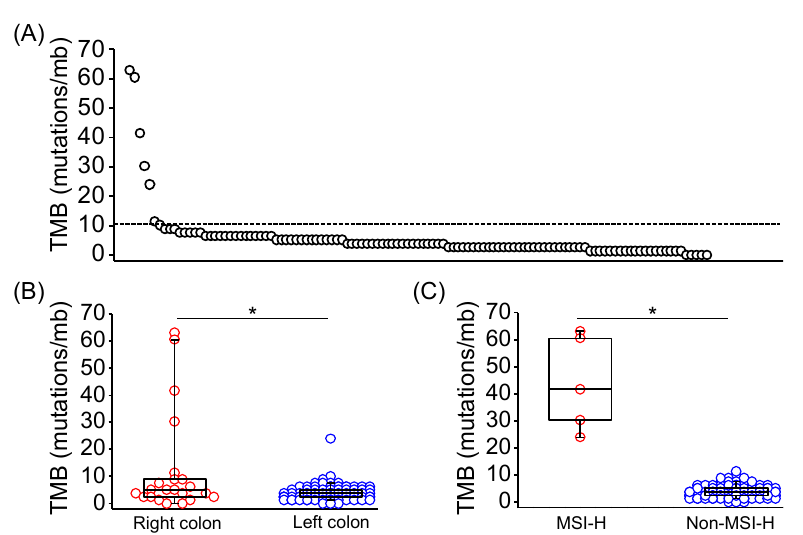
Figure 1. Tumor mutation burden in Taiwanese patients with mCRC. ( A ) TMB in each of 113 evaluated tumor tissues using the targeted-NGS technique. The dashed line indicated 10 mutations/mb. TMB in mCRC with distinct primary location ( B ), and MSI-H presentation ( C ) was shown and compared using the Mann Whitney U test. The horizontal line denoted the median, the upper and lower bottom of the box indicated the 25th and 75th percentile, and the whiskers marked the 5th and 95th percentiles. * represented p < 0.05.